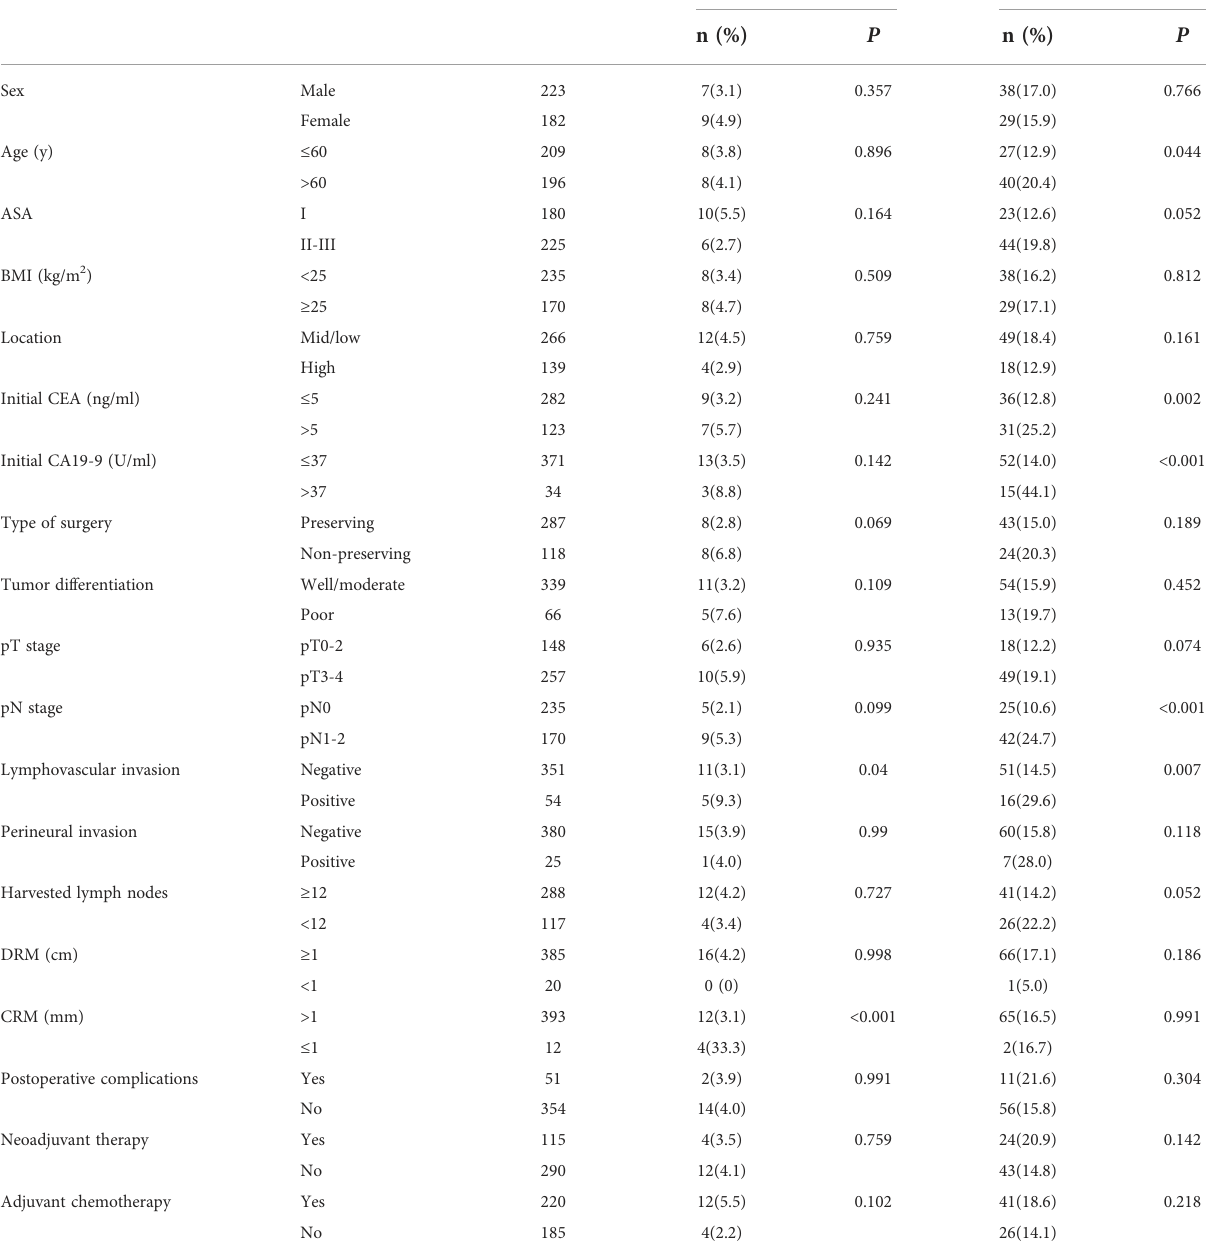
TABLE 3 Univariate analyses of risk factors for local and distant